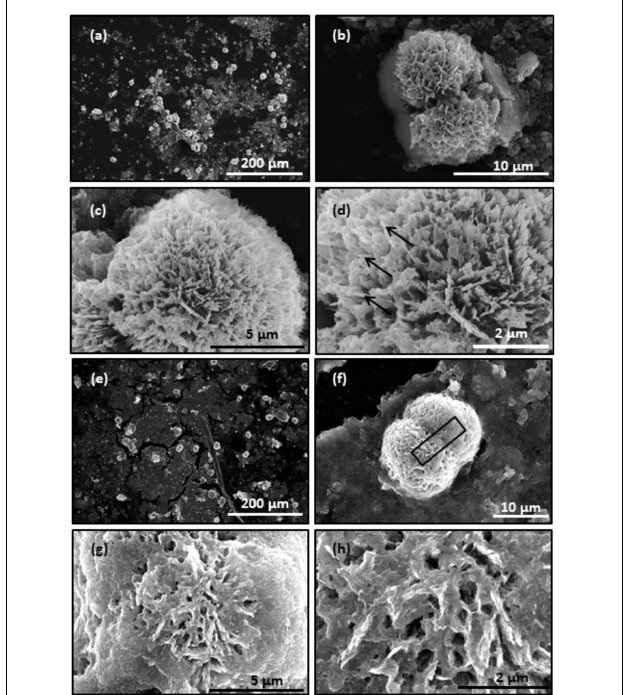
FIGURE 7 | Scanning electron microscopy observation of CaCO 3 crystals in the collagen gel. (a–d) No hrMMP-1 treatment; same region, different magnification. (e–h) hrMMP-1 treatment; same region, different magnification. The treatment of hrMMP-1 increased the interaction between collagen fibers and aragonite crystals. Black arrows show the needles covering the ball crystal. Black rectangle in (f) indicates the region where the cross-section was made for FIB-TEM analysis.